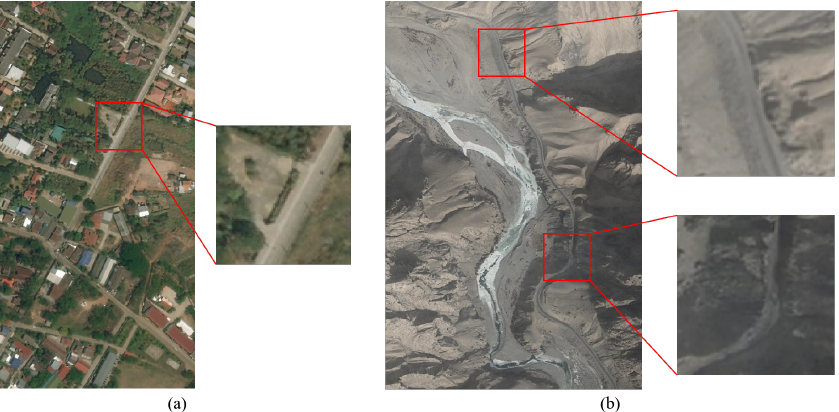
Figure 1. Characteristics of roads in different datasets: ( a ) is a clear road example in DeepGlobe; ( b ) is a road with a smaller edge blur width in RDCME.